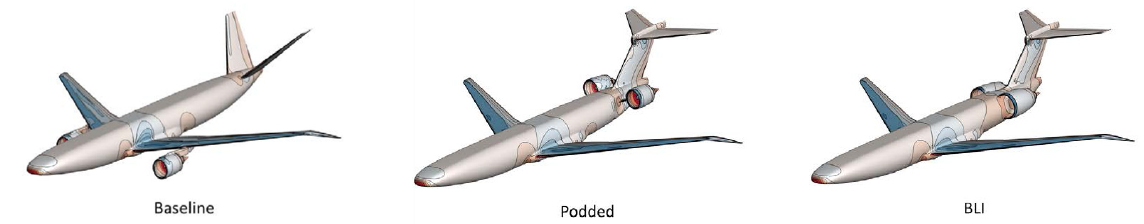
Figure 16. NOVA configurations used for UHBR engine integration. Table 3. NOVA configuration—drag increase (drag counts) for different engine